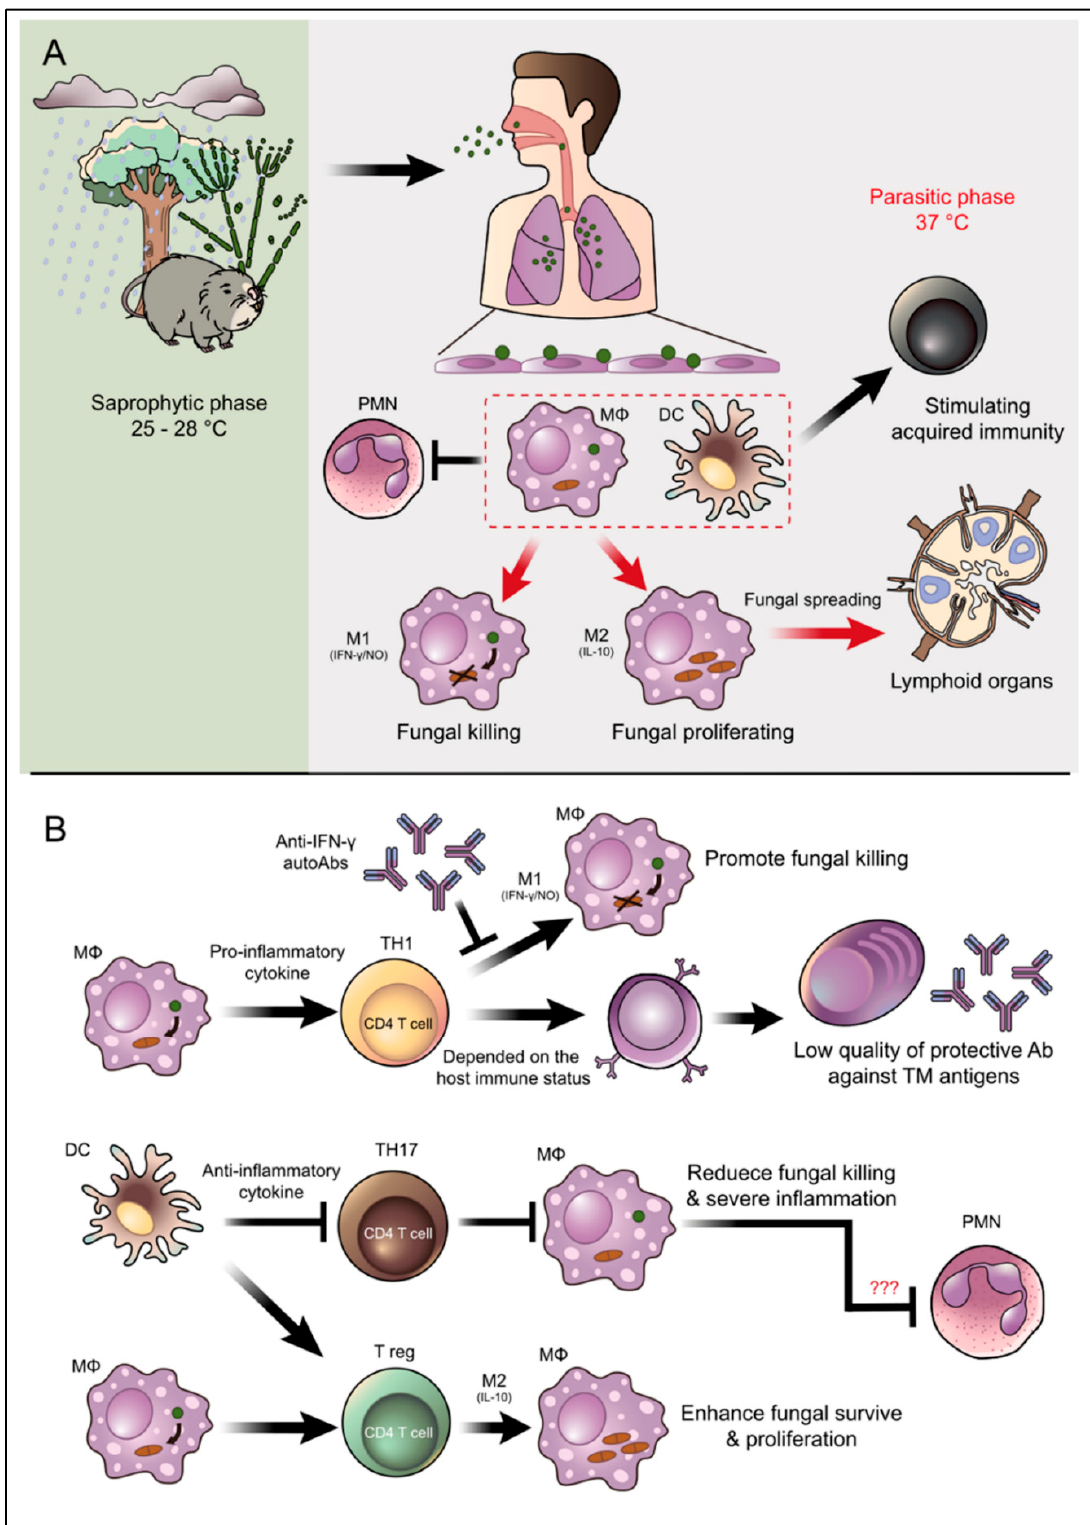
Figure 3. Overview illustration of infection, pathogenesis, and host defense mechanisms of T. marneffei . ( A ) T. marneffei grows in a saprophytic mold phase in the environment of endemic ar- eas. Bamboo rats are recognized as an important natural reservoir host of T. marneffei although the fungus is also soil associated. Infected individuals presumably inhale the aerosolized